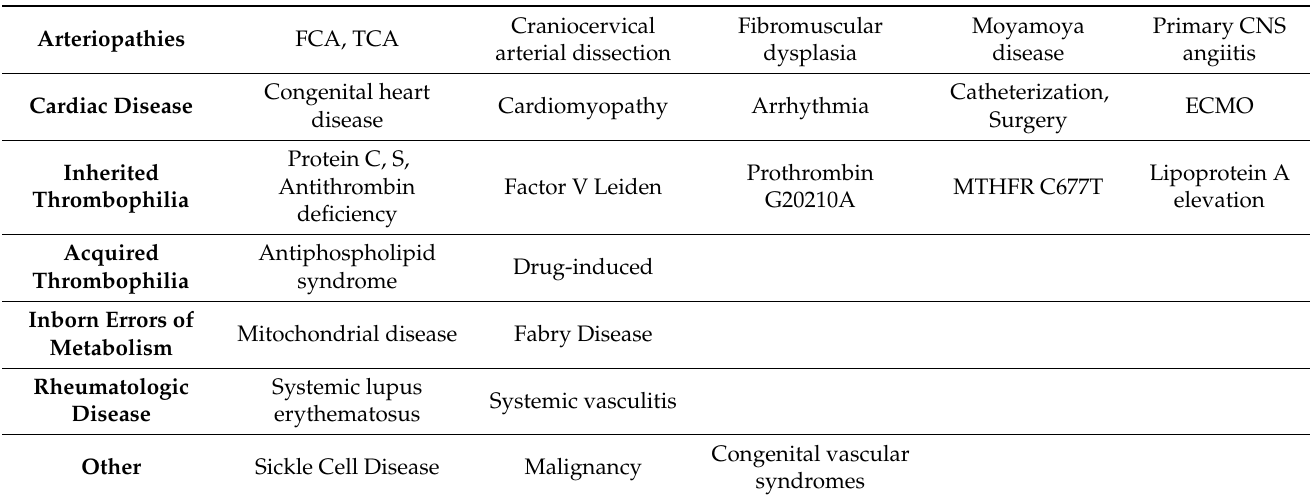
Table 2. Various risk factors for childhood